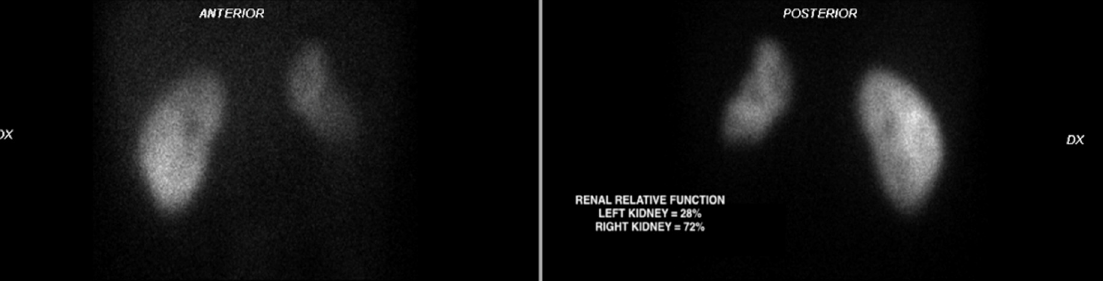
Figure 4. DMSA static renal scintigraphy at 30 days from discharge shows a small left kidney with reduced uptake of the tracer.